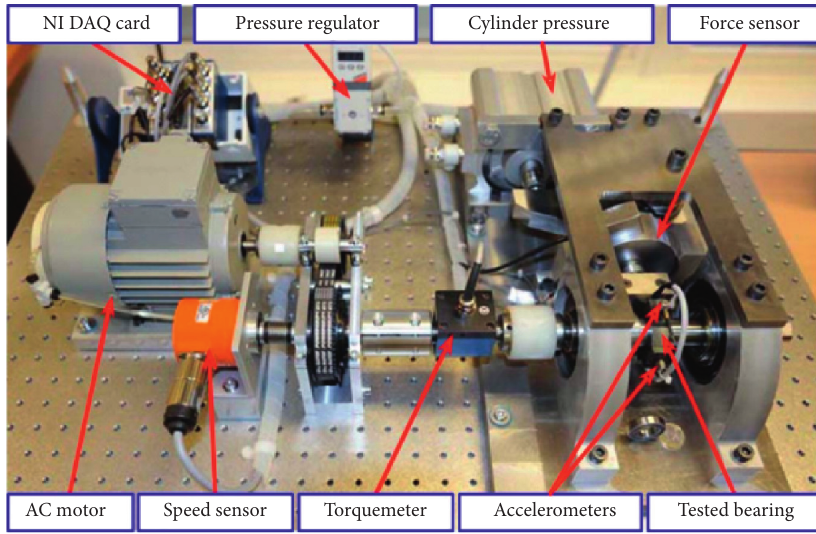
Figure 5: Overview of PRONOSTIA platform. Table 1: Bearing dataset with operational conditions.